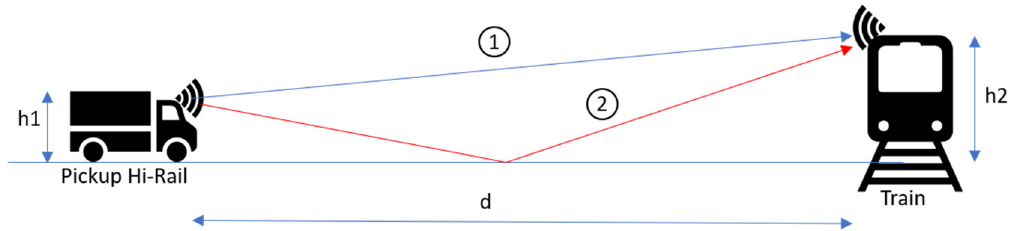
Figure 10. Ground reflection Train-Hi-Rail pickup.